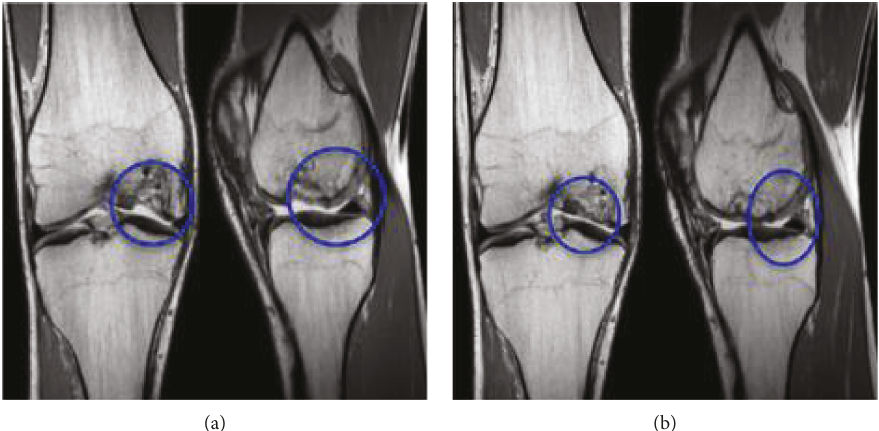
Figure 4: (a) Pretreatment proton density- (PD-) weighted coronal and sagittal MRI images of the knee showing the isolated chondral defect involving the central weight-bearing area of the medial femoral condyle. (b) Posttreatment PD-weighted coronal and sagittal MRI imaging at 18 months indicating articular cartilage regeneration at the site of the osteochondral defect [74].